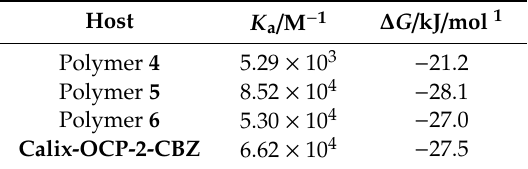
Table 3. Association constants ( K a ) and free energy changes ( ∆ G ) for the inclusion complexation with